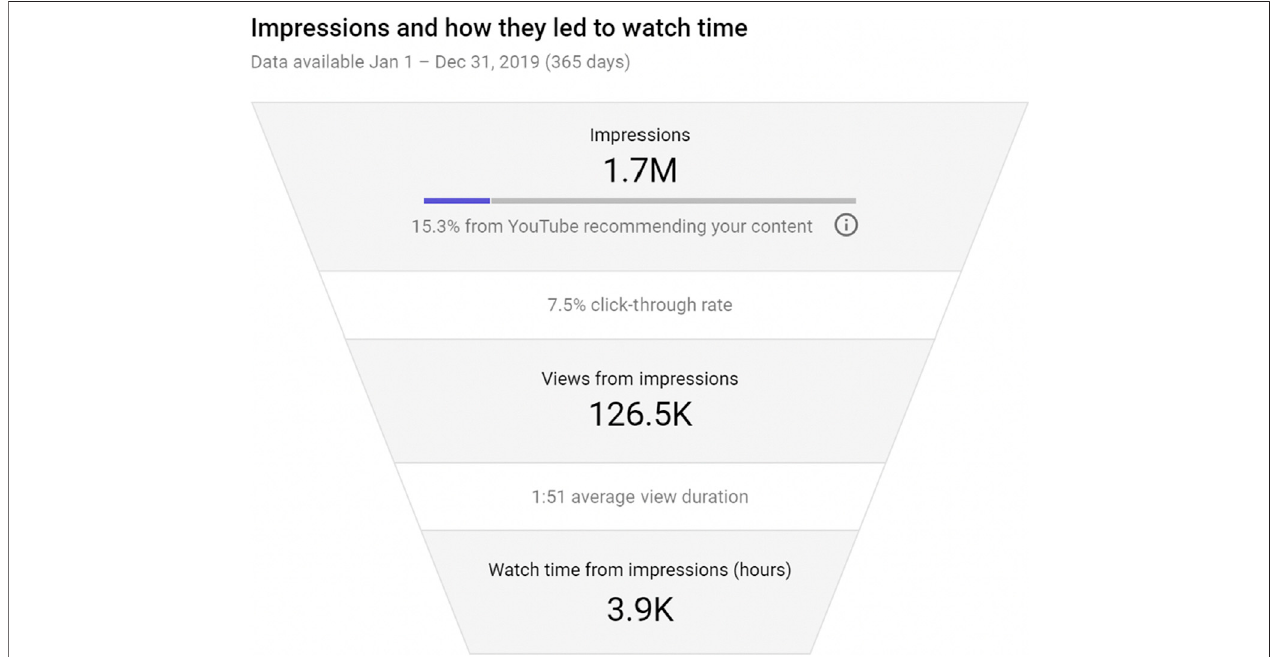
FIGURE 10 | Impressions click-through rate leading to watch time.